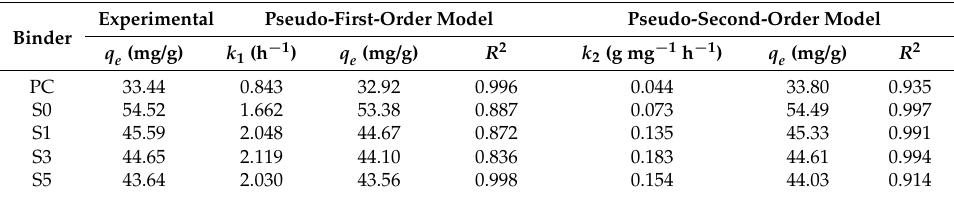
Table 4. Parameters of kinetic models of strontium adsorptions on various binder types.